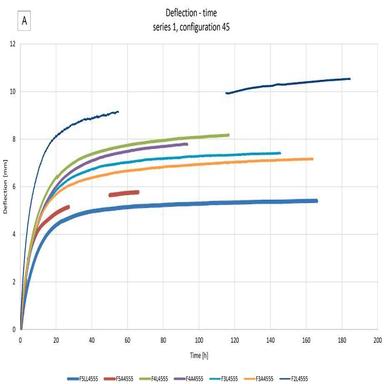
Maximum deflections over time of the first series, "configuration 45".